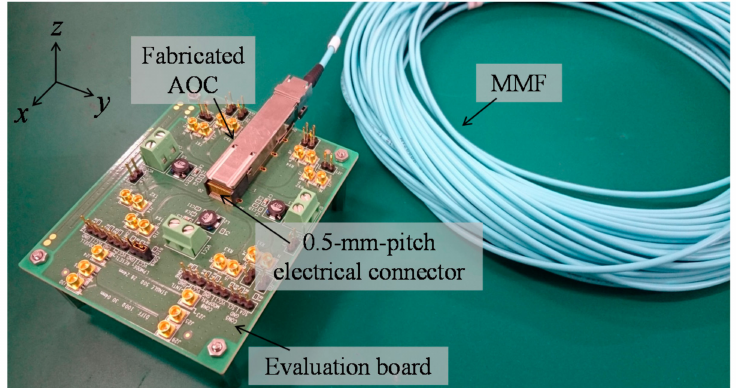
Figure 6. Photograph of fabricated AOC.